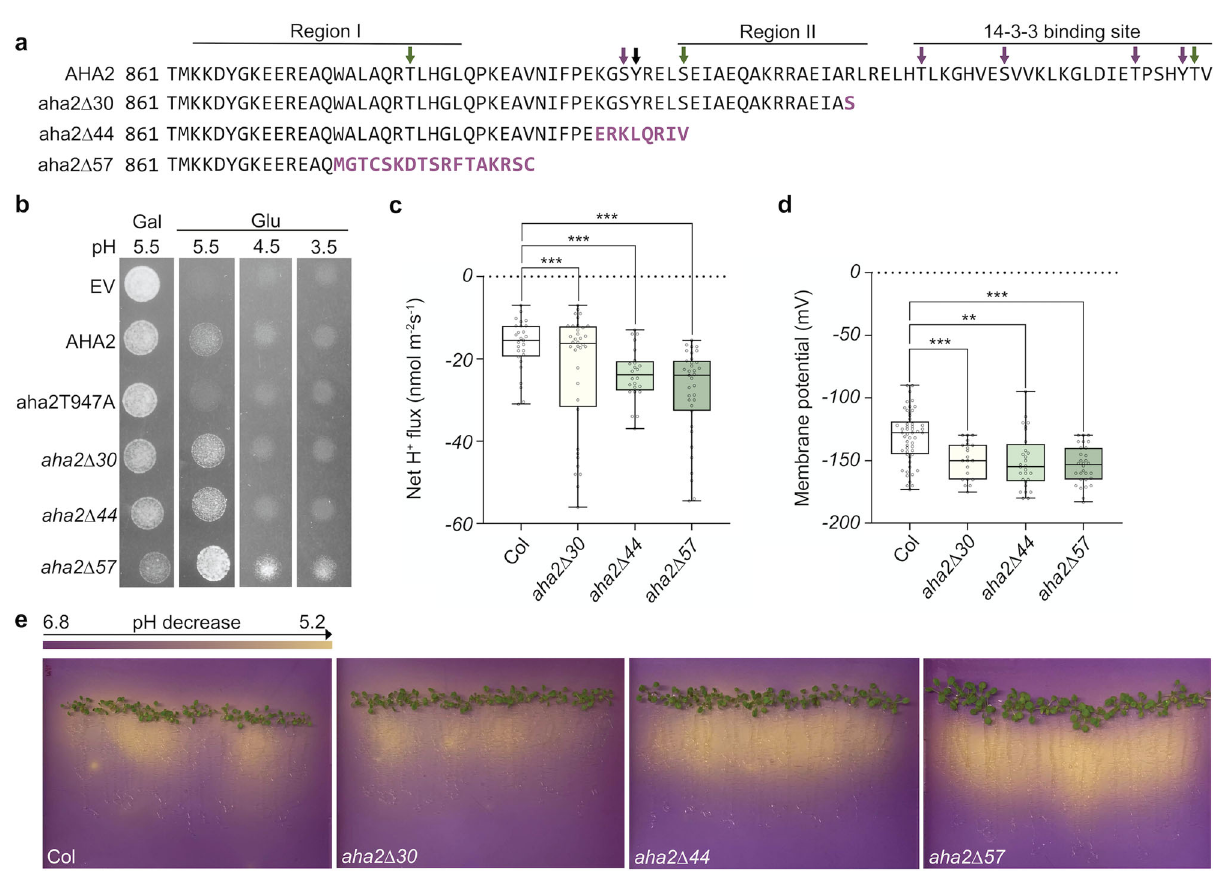
Fig. 3 Truncation of the C-terminal autoinhibitory region of AHA2 increases pump activity in vivo. a Indels in the AHA2 mutant lines generated by CRISPR-Cas9 resulted in premature stop codons resulting in the truncation of the C-terminal autoinhibitory domain. aha2 Δ 30 : line containing a 30-residue deletion with the predicted appearance of an additional nonsense residue. This truncation led to the removal of the 14 ‑ 3-3 protein binding site. aha2 Δ 44 : line containing a 44-residue deletion witha predicted appearance of eight nonsense residues. This truncation also removes Region II. aha2 Δ 57 : line containing a 57- residue deletion and predicted appearance of 17 nonsense residues. This truncation furthermore removes half of Region I, including a conserved phosphorylation site (Thr881) known to activate the protein independent of 14-3-3 protein. Nonsense amino acid residues are marked with purple bold lettering. Green arrows: phosphorylation activates AHA2; purple arrows: phosphorylation blocks activation of AHA2; black arrow: effect of phosphorylation is unknown. b Complementation of the yeast strain lacking endogenous plasma membrane H + -ATPase indicates that by truncating 57 amino acids from the C-terminal autoinhibitory domain, AHA2 is able to sustain yeast growth even when the pH of the medium drops to 3.5, suggesting a more active pumping of protons. aha2T947A functions as a negative control since the mutation leads to an inactive pump. The experiment was repeated three times with similar results. c Net H + fl uxes measured from the elongation root zones of 4 – 5 individual 6-day-old A. thaliana seedlings from each line with 3 – 9 measurements per seedling ( n ≥ 24; P < 0.001; ***, pairwise t -test). d Truncation of the AHA2 C terminusleads to decreased membrane potentialin6-day-old A. thaliana roots with 3 – 9 measurements made in 3 – 8 individual plants from each line ( n ≥ 21; ** P <0.01; *** P < 0.001; pairwise t -test). e Visualization of increased acidi fi cation capacity around the root system of approximately 2-week-old plants. To detect the medium ’ s pH change, bromocresol purple was applied at pH 6.5. The experiment was repeated three times with similar results. The boxes extend from the 25th to 75th percentiles, with whiskers ranging from minimum to maximum values. The centerlines indicate the medians and the black circles show each data point from the